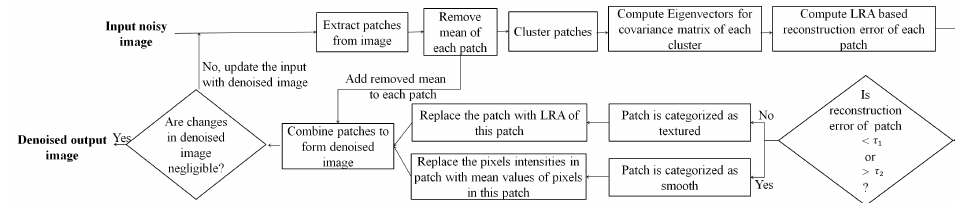
Figure 5. Illustration of major steps in the proposed denoising